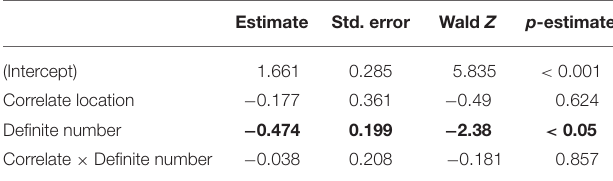
TABLE 4 | Experiment 1: results of linear mixed effects regression model on the proportion of transformed responses. Estimate Std.